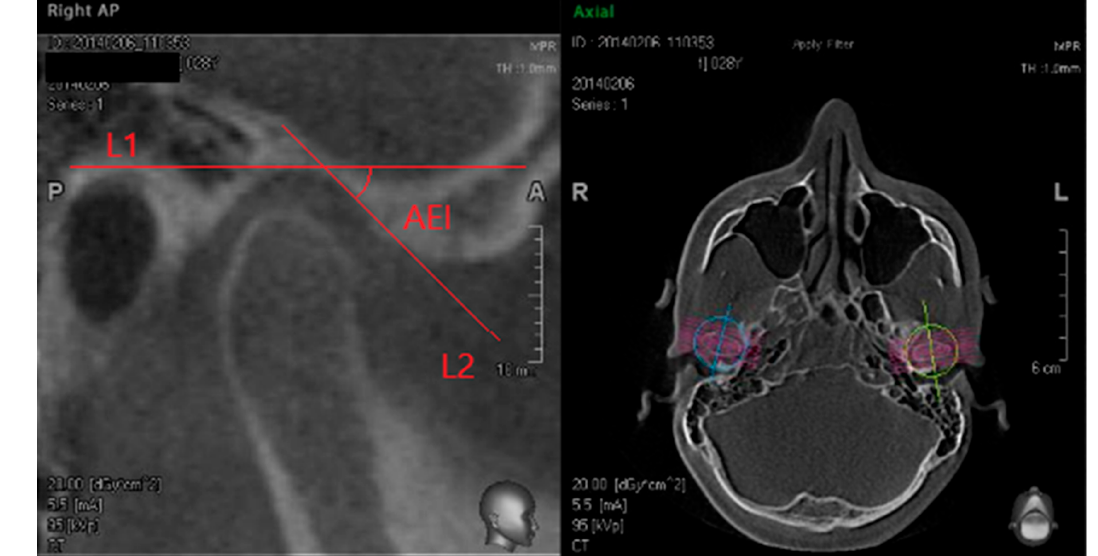
Figure 1. Graphic method to measure Articular Eminence Inclination. The mid-sagittal section of the condyle was separately extracted on the right and left. On the axial view, the section of the condylar process that had the widest mediolateral diameter was chosen as the reference view for reconstruction of the sagittal slices. In this section, a line orthogonal to the mediolateral diameter of the condyle and parallel to the long axis of the condylar process was drawn, so sagittal images were reconstructed as 0.5 mm slice interval/thickness and the most central one was taken. Legend: L1: line 1, a horizontal line, parallel to the Frankfurt plane (FH) passing through the uppermost point of the glenoid fossa; L2: line 2, constructed along the posterior slope of articular eminence, connecting the lowermost and most posterior point of the articular eminence and the uppermost and most anterior point of the glenoid fossa on the temporal bone; AEI: Articular Eminence Inclination, the angle measured between the two lines.